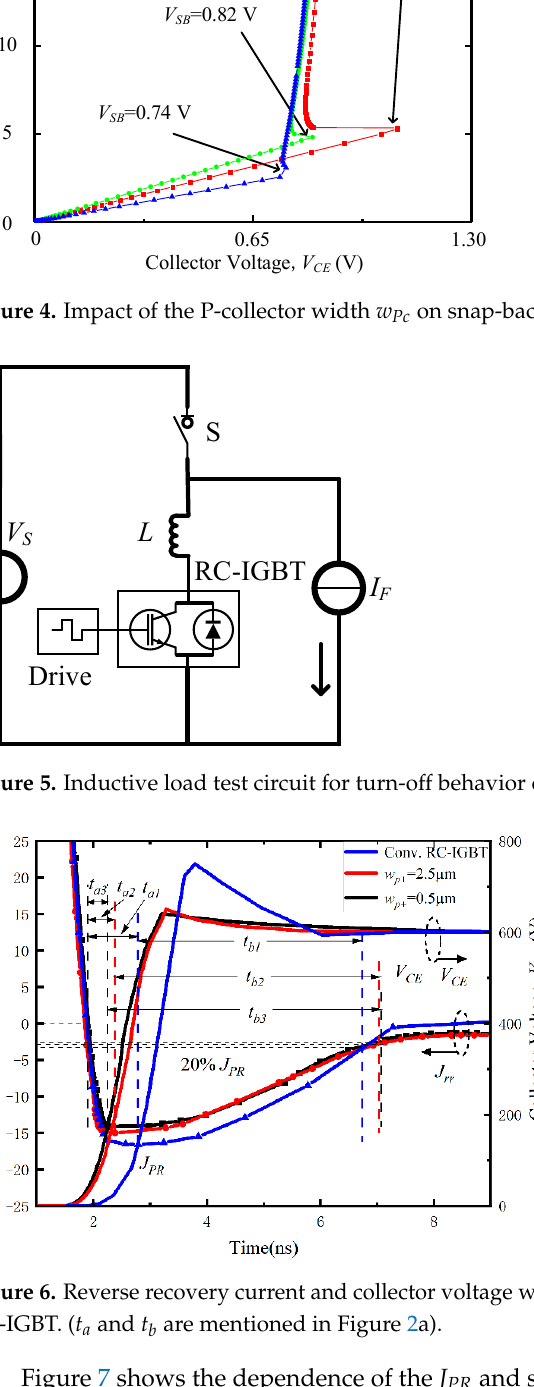
Figure 4. Impact of the P-collector width w Pc on snap-back.